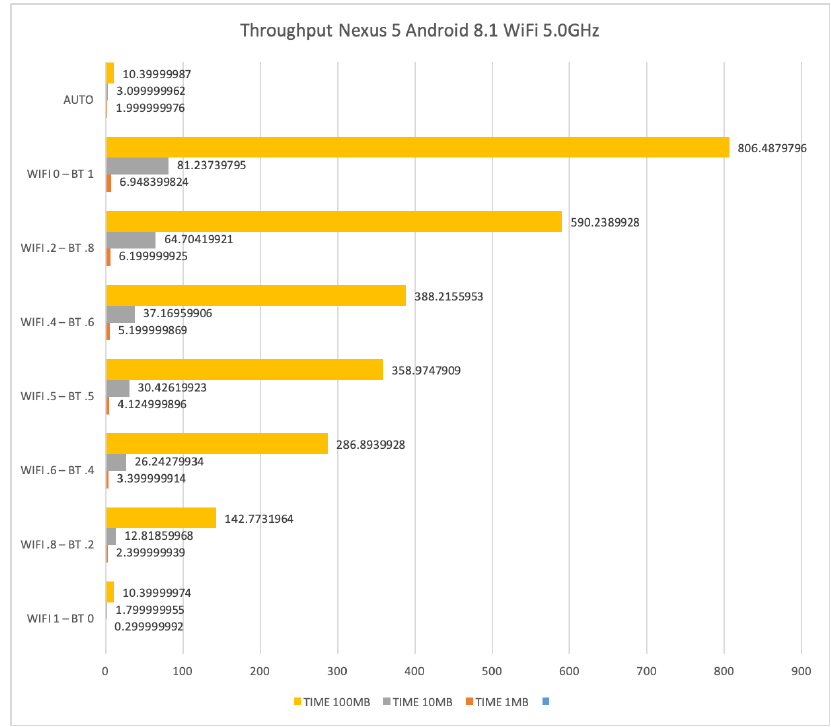
Figure 20. Time required for transferring files of size 1 Mb, 10 Mb and 100 Mb by means of WiFi at 5 GHz and Bluetooth on a LG Nexus